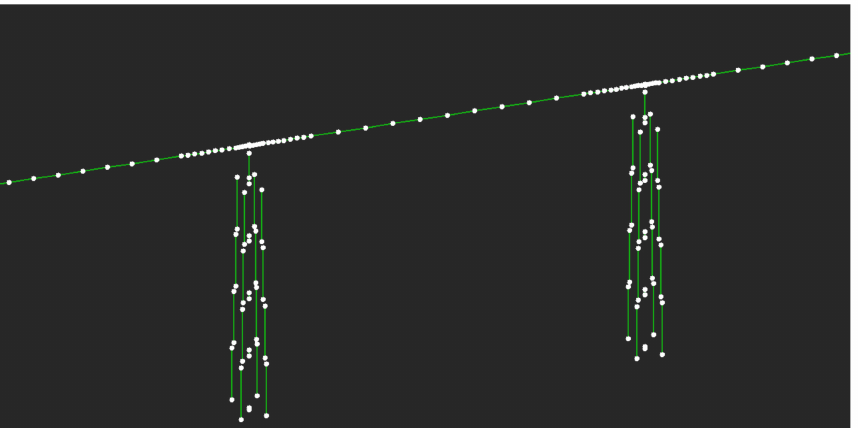
Figure 16. OpenSees model visualization.